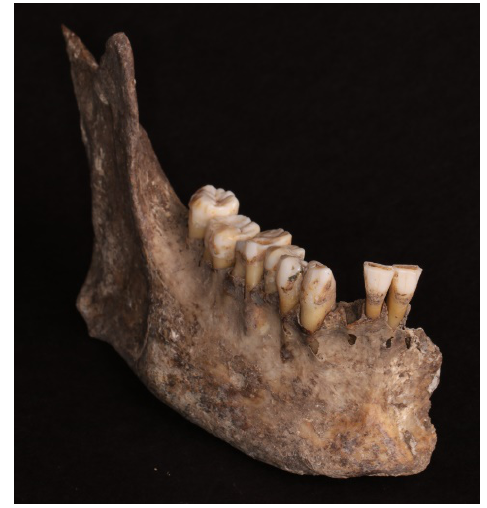
Figure 3. Shengavit: excavations of the 4th